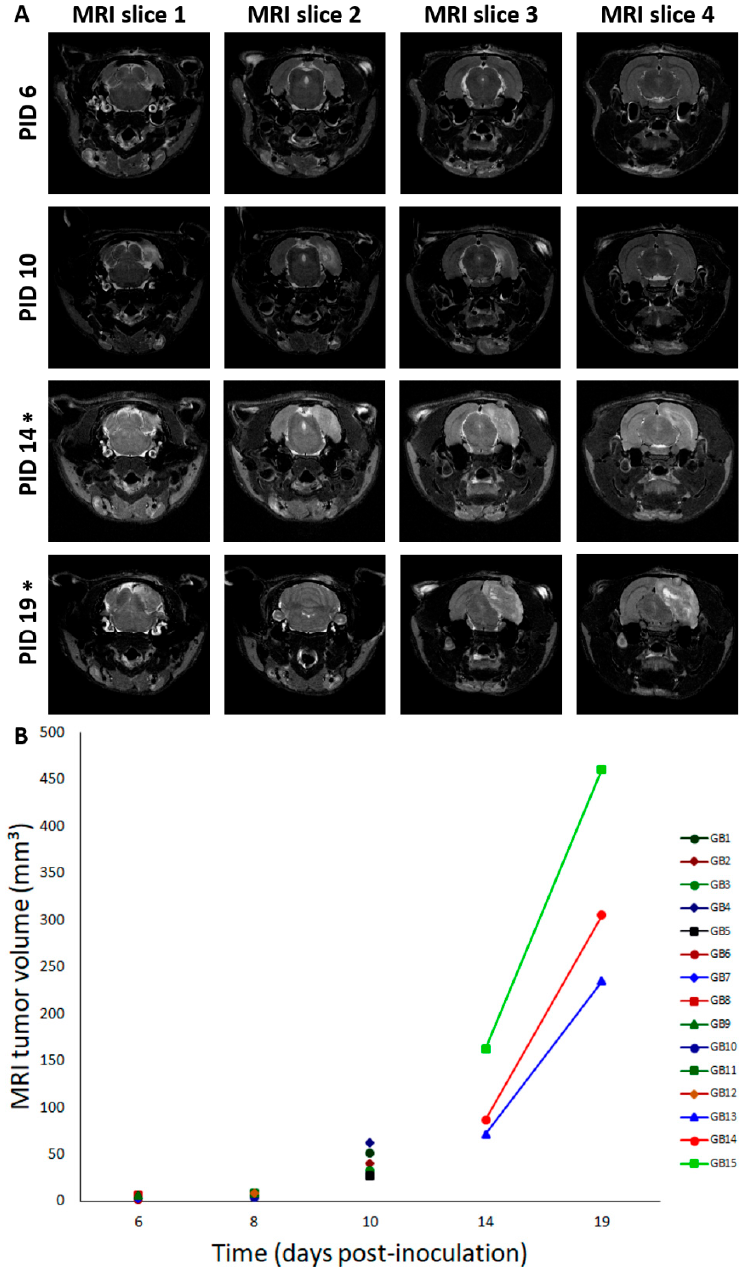
Figure 1. Tumor evolution and deformation of the brain over time. ( A ) Deformation of the brain over time. This figure shows consecutive (MRI slice 1 to 4, posterior to anterior) T2 MRI images (slice thickness: 0.6 mm—interslice thickness: 1.2 mm) in a rat brain at different time points: PID6: Hyperintense T2 signal at inoculation site (GB9); PID10: three distinct tumor zones can be identified (GB5); PID14: large tumor starts to deform the brain (GB14); PID19: massive tumor deforms the brain, pushes on the brainstem, and causes a midline shift (GB14). T2 MRI images “MRI slice 2” are taken around the inoculation site, while T2 MRI images “MRI slice 4” are taken close to the electrodes implanted in the hippocampi. PID—post-inoculation day. * indicates that images of PID14 and PID19 are obtained in the same GB animal (GB14). ( B ) Tumor volumes on MRI for different GB rats in function of time. In this graph, MRI tumor volumes for individual rats are shown for different points in time (days post-inoculation). Note that overlay of rats is present on PID6 (GB6–7 and GB8–9) and PID8 (GB11–12). Lines connect MRI tumor volumes of the same rats at different time points.